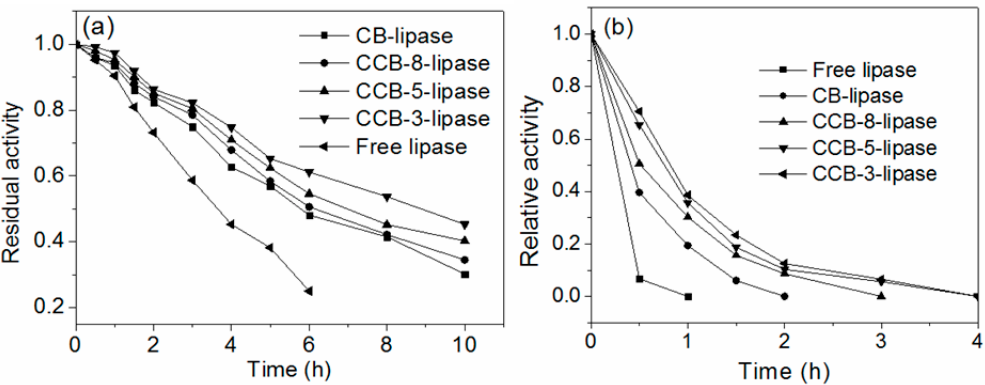
Figure 6. Thermal stability of free and immobilized lipases after heating treatment at 30 °C ( a ) and 60 °C ( b ). Substrate concentration: 0.18 g/mL, 0.2 g immobilized beads, pH 7.0 for free lipase and pH 7.5 for immobilized lipase.